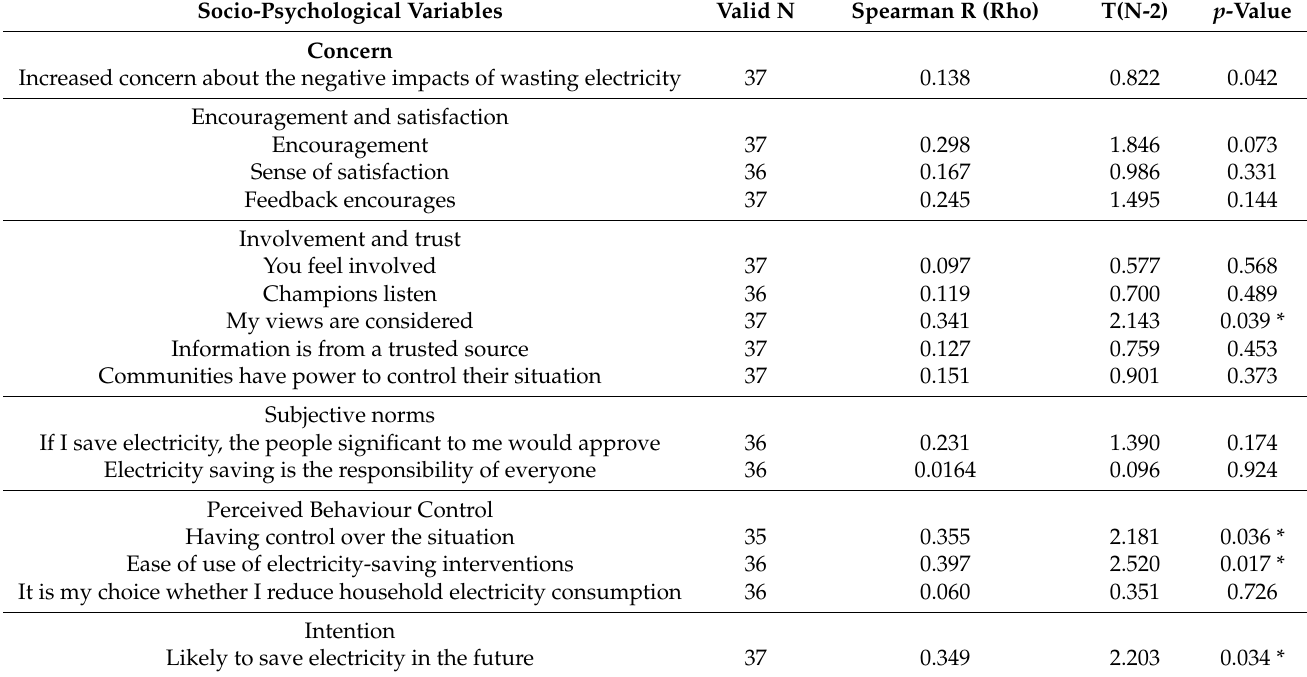
Table 5. Spearman correlation coefficient between electricity savings and socio-psychological